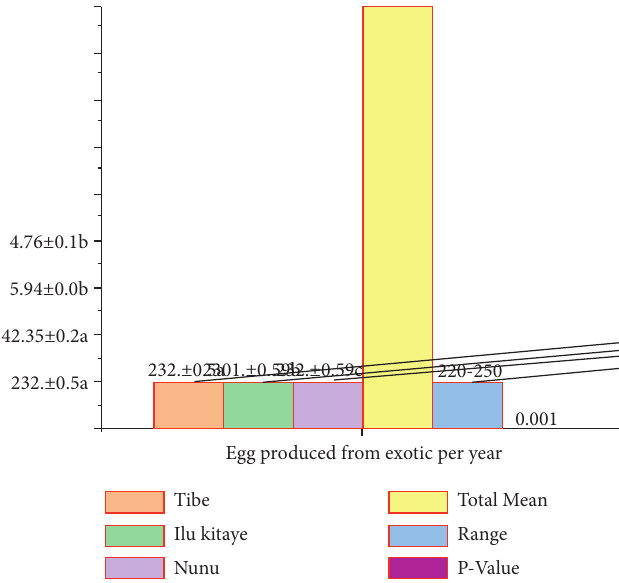
Figure 5: Historical representation of result analyzed for three